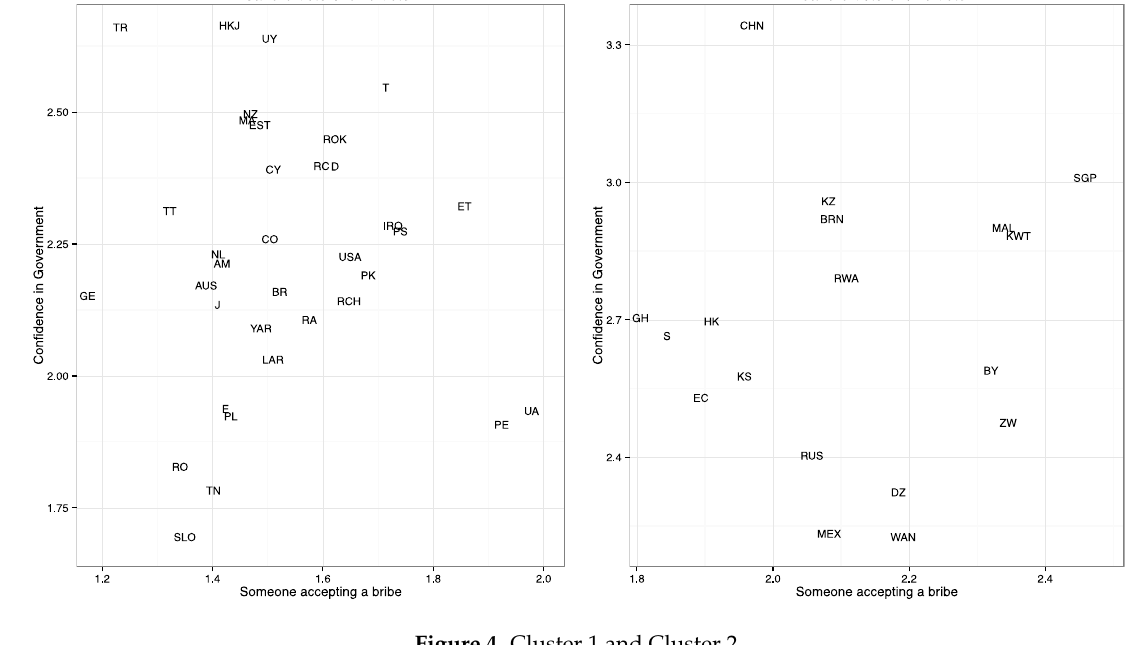
Figure 4. Cluster 1 and Cluster 2.